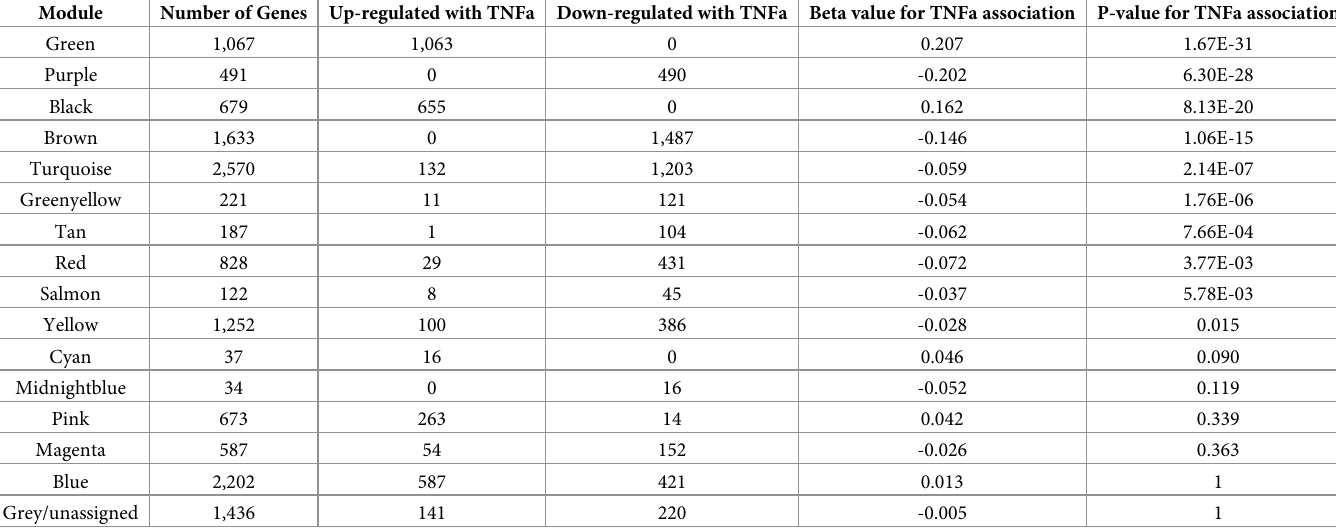
Each gene module is assigned a color, with grey reserved for genes not assigned to any module. The number of genes in each module is given, followed by the number of genes in that module that were significantly up- or down-regulated with TNFa according to individual gene tests in limma . The last two columns contain regression beta values and Bonferroni-adjusted p-values from linear mixed models testing the association of module eigengenes (the first principal component of gene expression in each module) and treatment with TNFa.